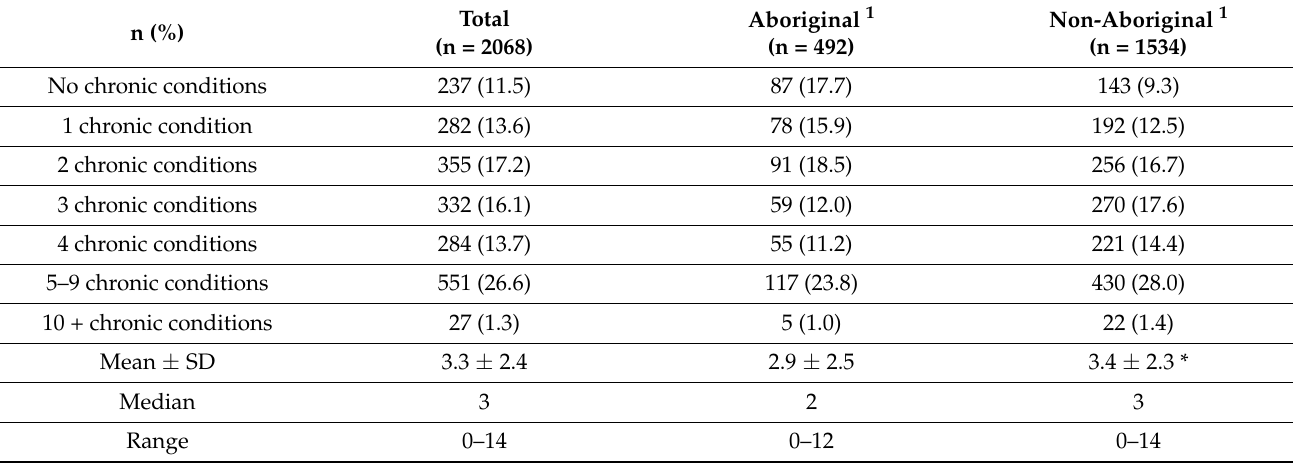
Table 6. Multimorbidity Among Homeless Healthcare